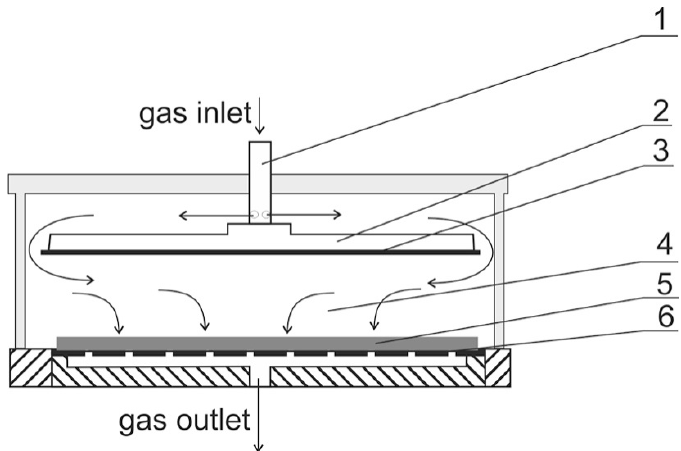
Figure 2. The scheme of the reactor. The arrows indicate the direction of the gas flow. 1 = gas inlet, 2 = high-voltage electrode, 3 = dielectric barrier, 4 = discharge gap, 5 = modified sample, and 6 = grounded electrode [25].